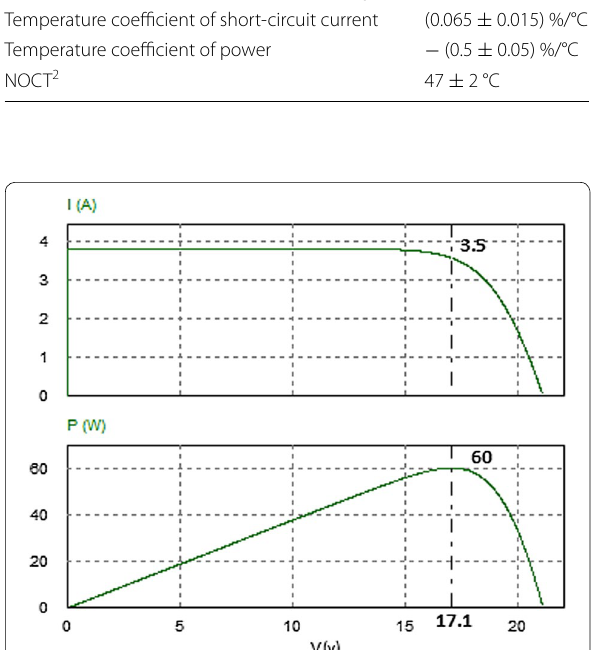
Fig. 3 I – V and P – V curves for PV panel